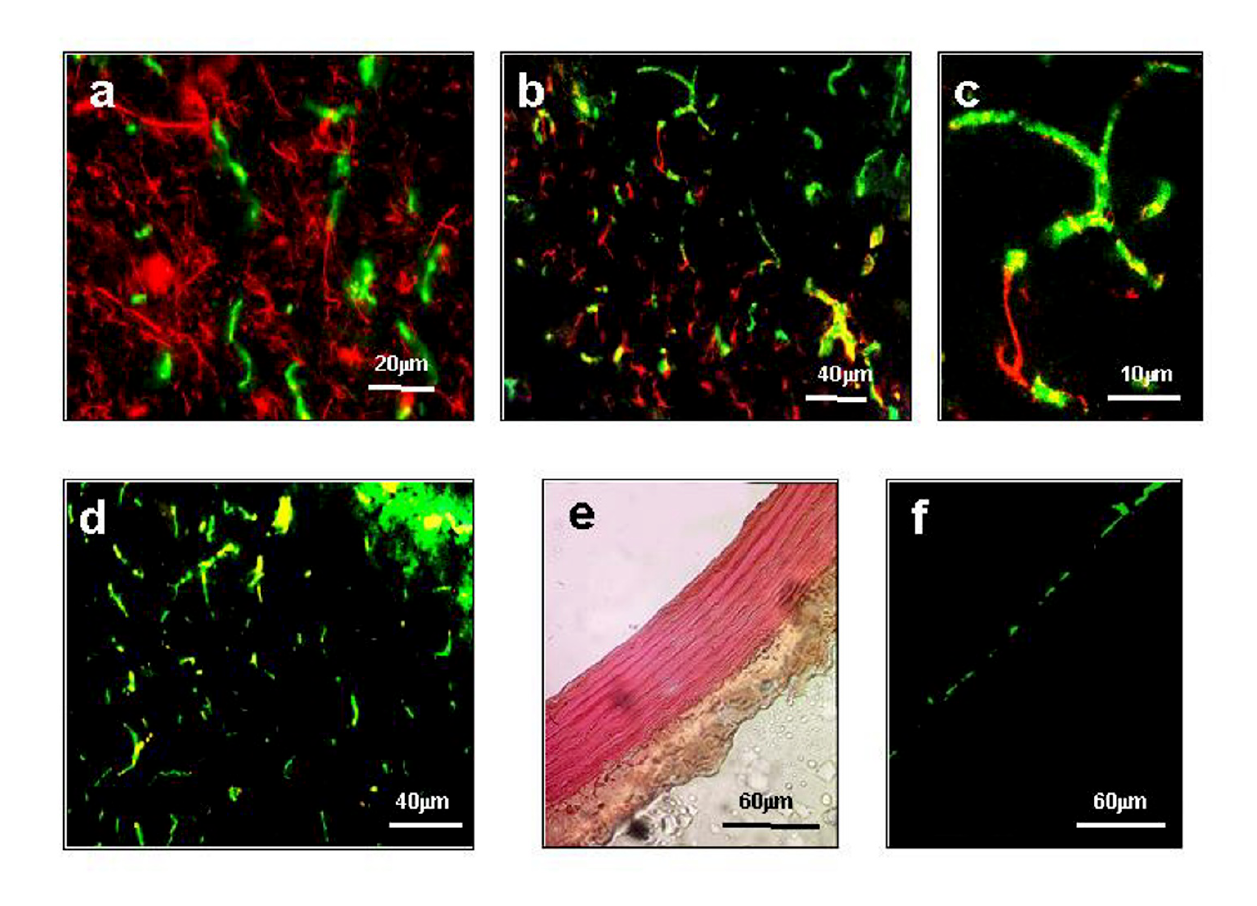
Figure 3 Colocalization of β -dystroglycan and von Willebrand factor in normal mouse forebrain. Shown are cryosections indirectly labeled with rhodamine-conjugated antibodies to the neurofilament of apparent 68 kDa (a), the glial fibrillary acidic protein (b, c) and von Willebrand factor (d). Sections (a) to (d) were indirectly double-labeled with a fluorescein-conjugated antibody against β -dystroglycan. To demonstrate the specificity of the antibody to von Willebrand factor, rat aorta sections are shown in (e) (Haematoxylin & Eosin staining) and (f) (immunofluorescence labeled). In (a), bar = 20 µ m; in (b) and (d), bar = 40 µ m; in (c), bar = 10 µ m; and in (e) and (f), bar = 60 µ